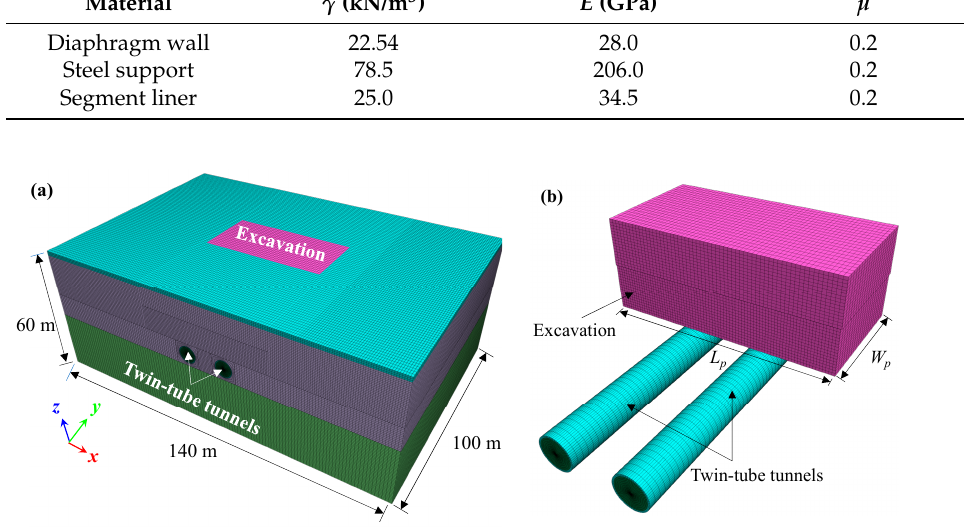
Figure 13. 3D finite element mesh, ( a ) the whole mesh, ( b ) location relationship between foundation and twin-tube tunnels.